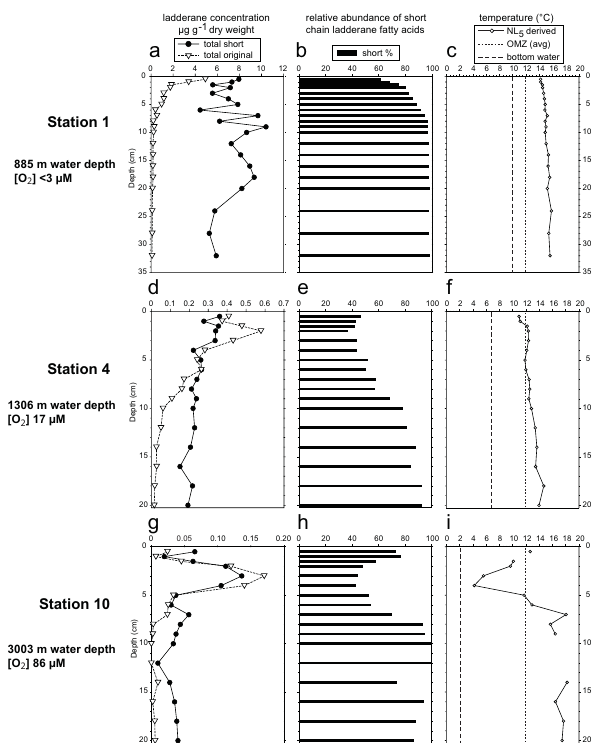
Fig. 6. Vertical distributions of concentrations of ladderane fatty acids (original: open triangles; short chain: filled circles), propor- tion of short chain ladderane fatty acids, and temperatures (open lozenges: NL 5 - derived temperature; dotted line: oxygen minimum zone average temperature; dashed line: bottom water temperature at station) in Arabian Sea sediment cores. Station 1 ( a , b , and c ), Sta- tion 4 ( d , e , and f ) and Station 10 ( g , h , and i ). Samples were taken during R/V Pelagia cruise 64PE301.